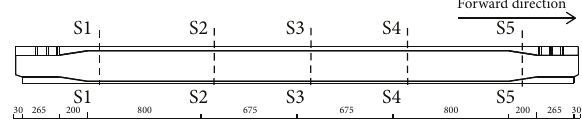
Figure 10: Critical control section of test box girders (cm).